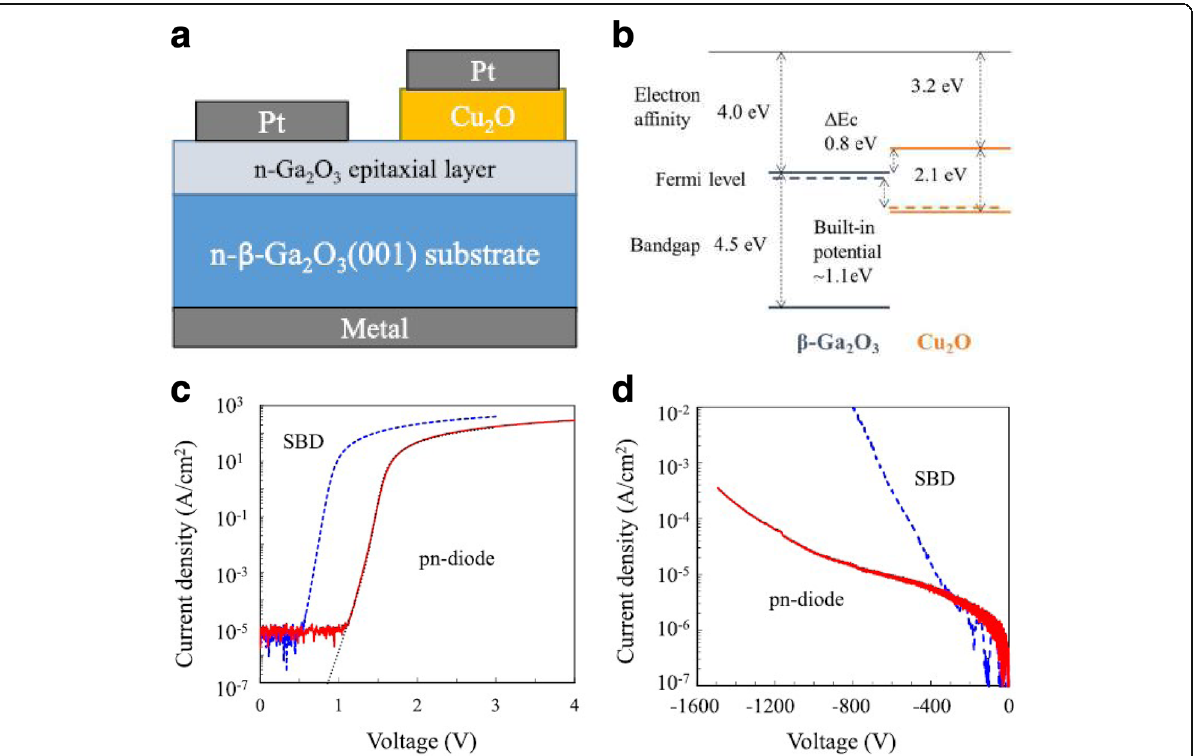
Fig. 11 a Schematic of the cross-sectional Pt/Ga 2 O 3 SBD and p-Cu 2 O/n-Ga 2 O 3 diode. b Band diagram of the p-Cu 2 O/n-Ga 2 O 3 interface. c , d Forward and reverse J – V characteristics of the SBD and p-n diode. Reprinted from ref.